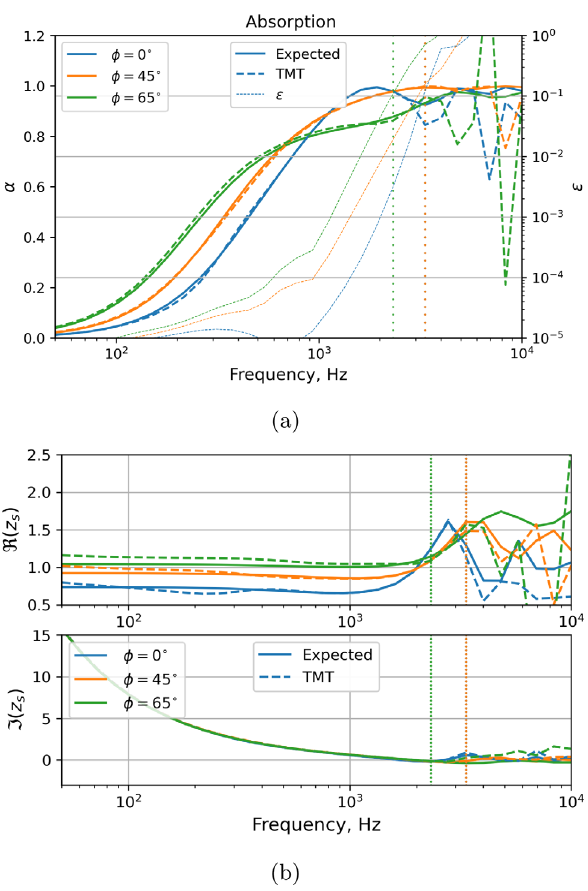
Figure 8. Absorption coef fi cient a and reproduction error (cid:2) (a), normalized surface impedance z s (b), for the con fi guration shown in Figure 1 for three incidence angles with a = 105 cm, b = 40 cm, h = 45 (cid:3) , k = 10 (cid:3) 7 , d = 2 cm, z a = 0.5 cm. Vertical dotted lines symbolise the estimated HF limit. TMT stands for Two-Microphone